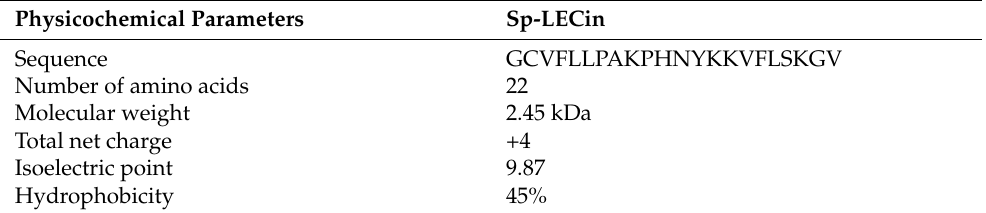
Table 1. The sequence and key physicochemical parameters of